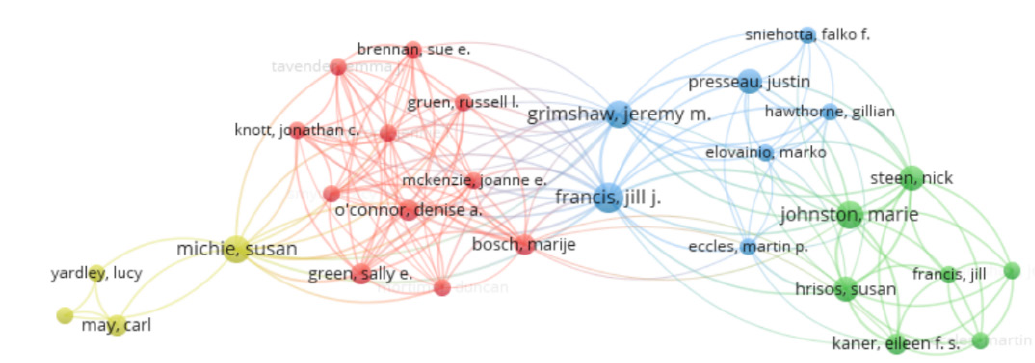
Figure 7. Fragment of author clusters